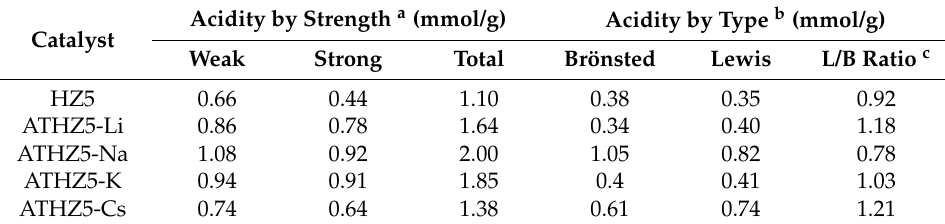
Table 2. Catalyst acidity results obtained by NH 3 -TPD and Py-IR.